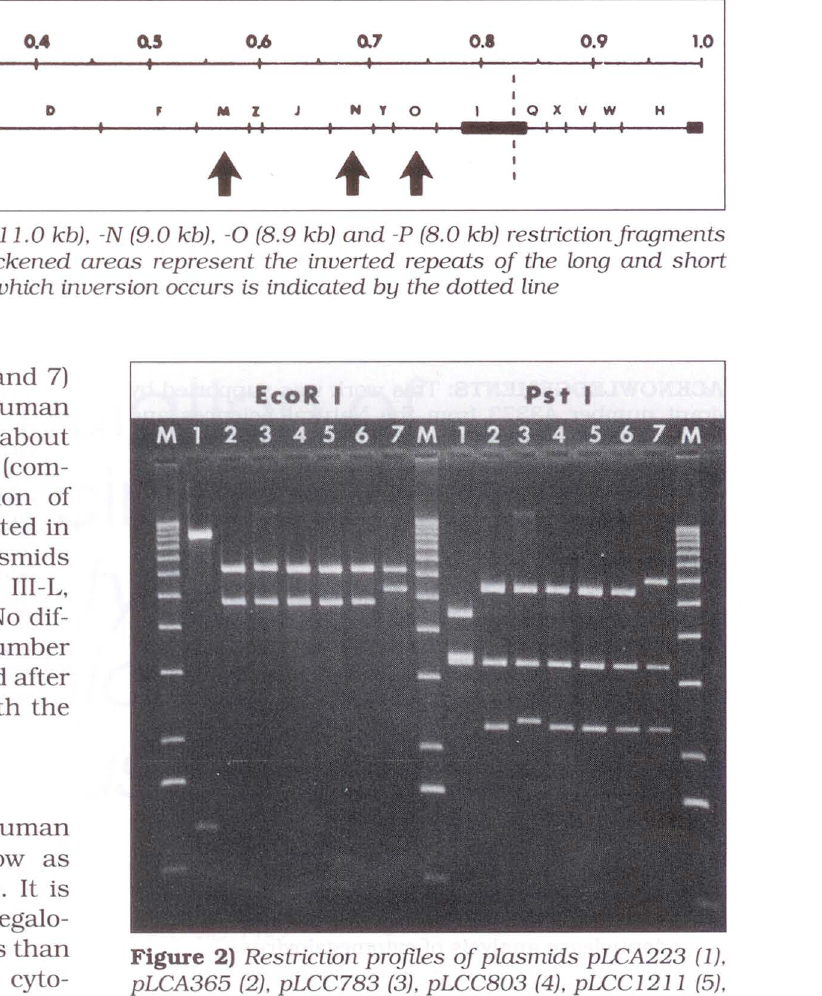
Figure 2) Restriction profiles of plasmids pLCA223 {1), pLCA365 (2), pLCC783 (3), pLCC803 (4), pLCC1211